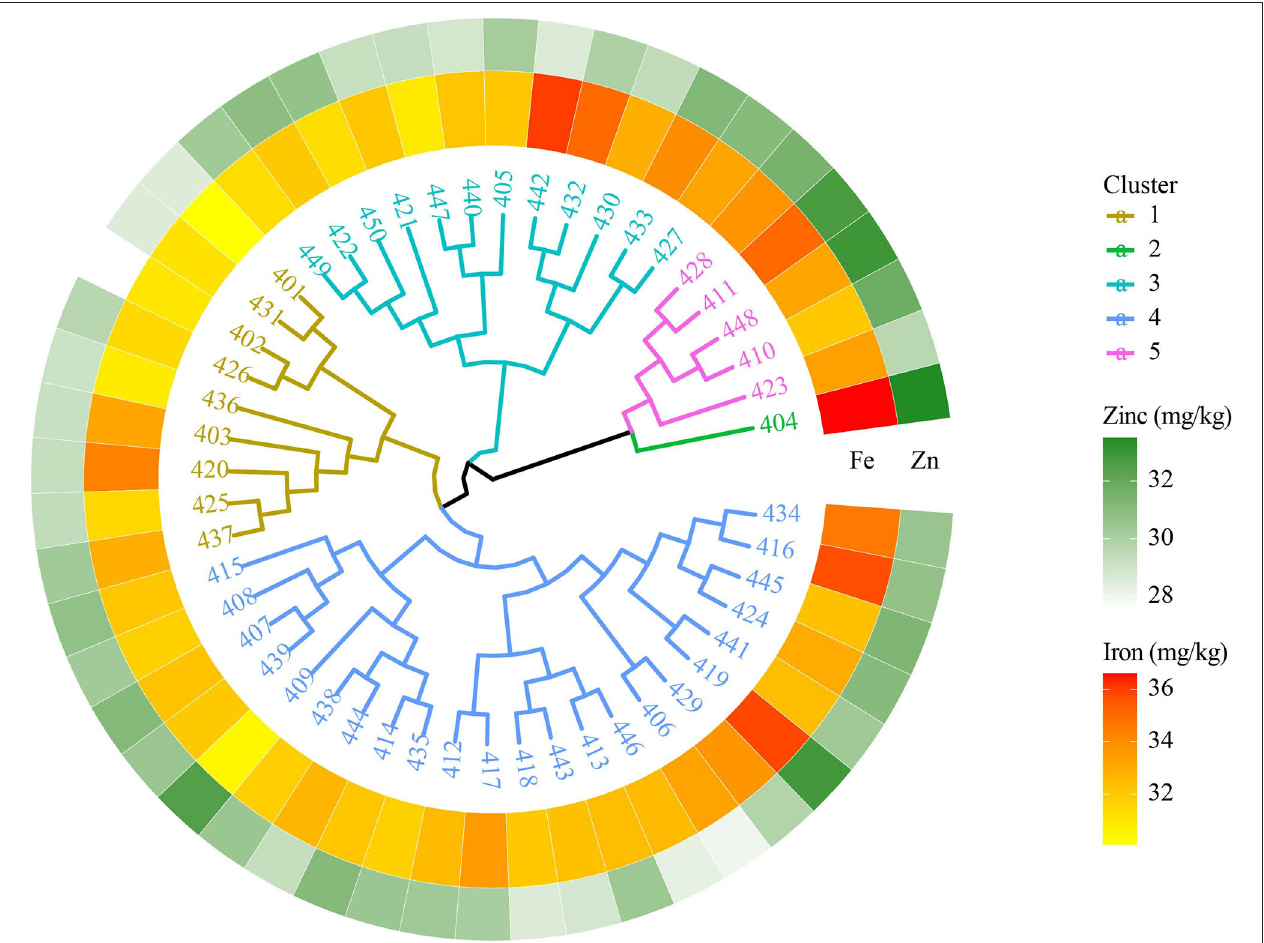
FIGURE 4 | Clustering of biofortified bread wheat genotypes from the 9th HPYT based on BLUP